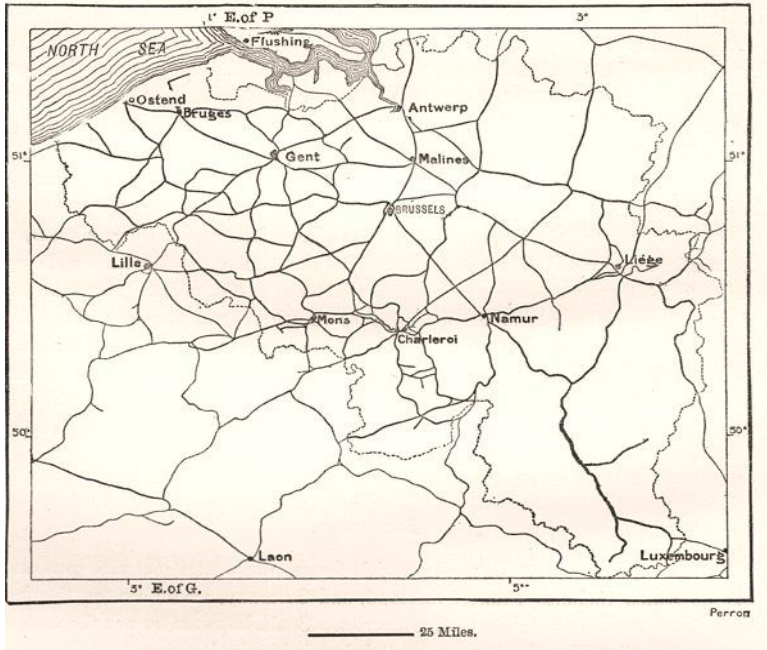
Figure 14. Railway Map of Belgium. Sketch map 1885 old antique vintage plan chart.